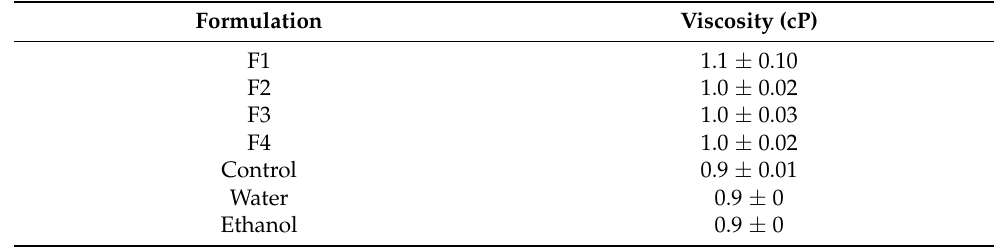
Table 3. The viscosity values of hand sanitizer gel formulations. The result represents the mean ± SD of three replicates ( n =